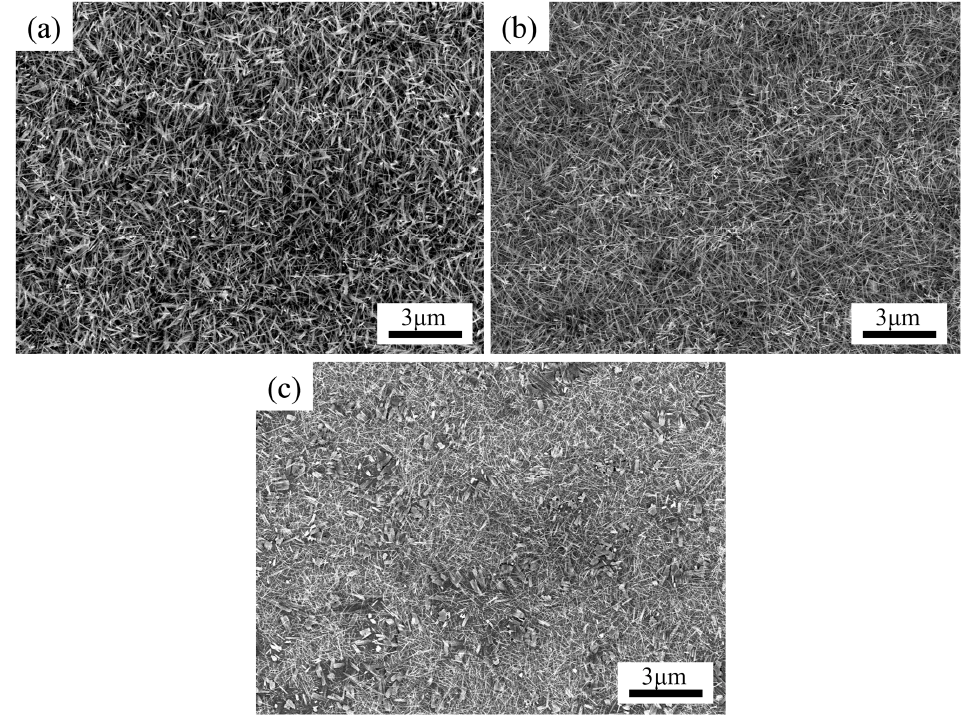
Figure 4. SEM images of NWs grown at carrier gas Ar fl ow rate of ( a ) 0, ( b ) 5, and ( c ) 50 sccm at 700 °C and 0.1 torr for 1.5 h.